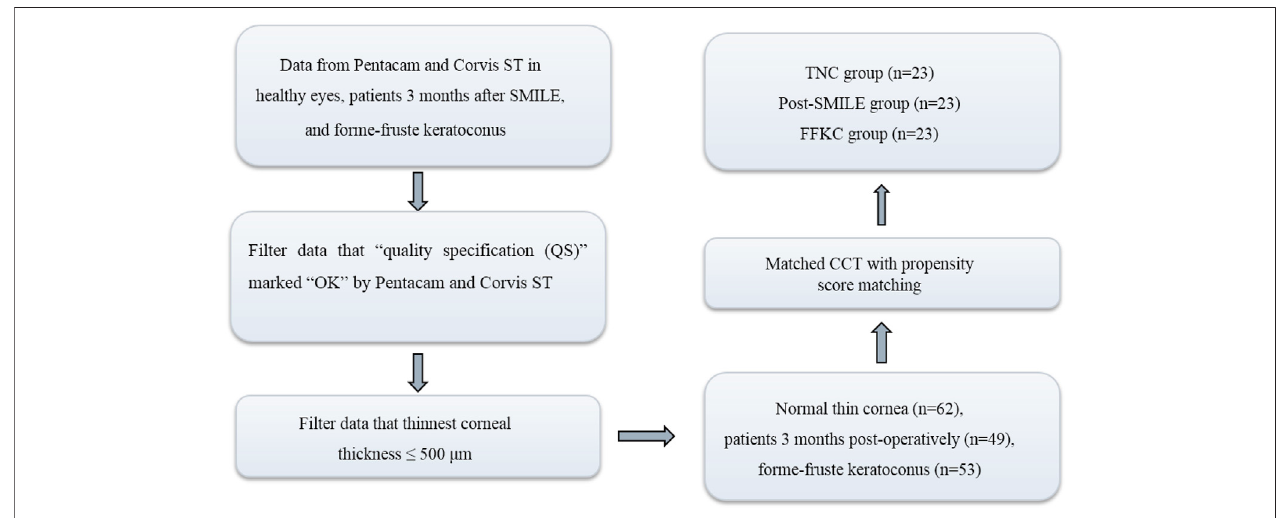
FIGURE 1 | Standard fl